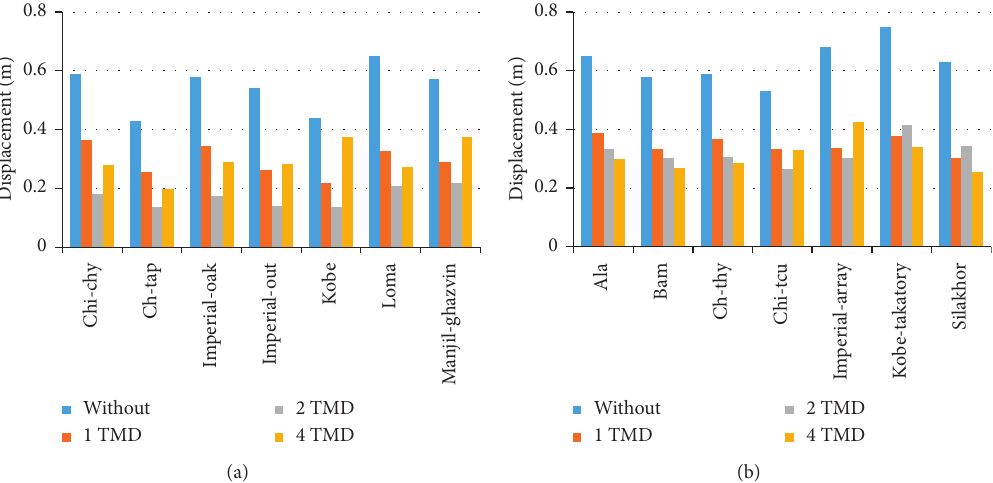
Figure 15: Displacementwith damperin theninth storyunder thenear-field(right) and far-field(left) earthquakesin theregular10-story